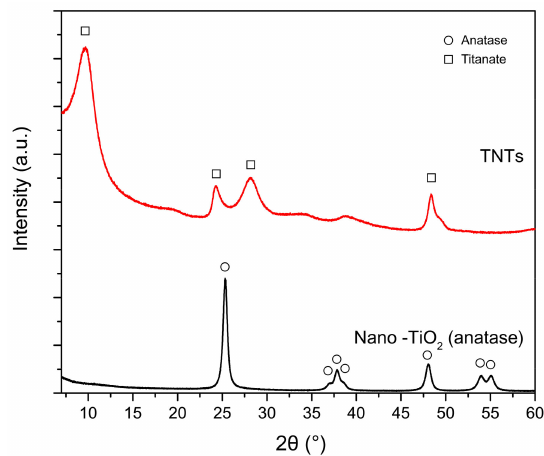
Figure 4. XRD spectra of pure anatase nano-TiO 2 and TNTs.